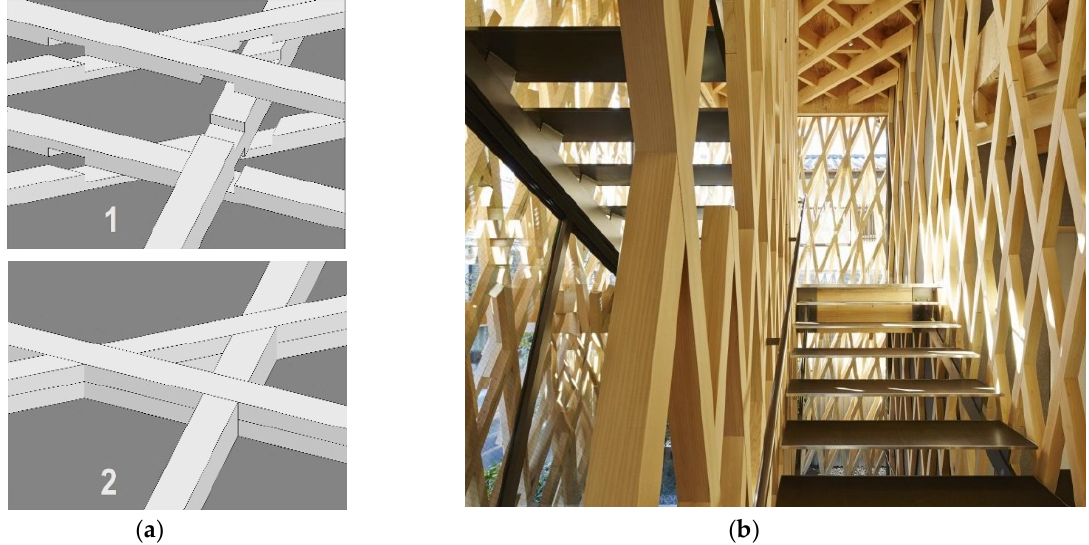
Figure 6. ( a ) The Halved Joint Yusuhara Wooden Bridge Museum (2011), by Kengo Kuma drawings: Piotr Arlet; ( b ) Tokyo, Sunny Hill (2013), Kengo Kuma; source: https://divisare.com/projects/313651-kengo-kuma-and-associates-edward-caruso- Sunny Hill (2013), Kengo Kuma; source: daici-ano-sunnyhill-tokyo-japan (accessed on 6 June 2021).